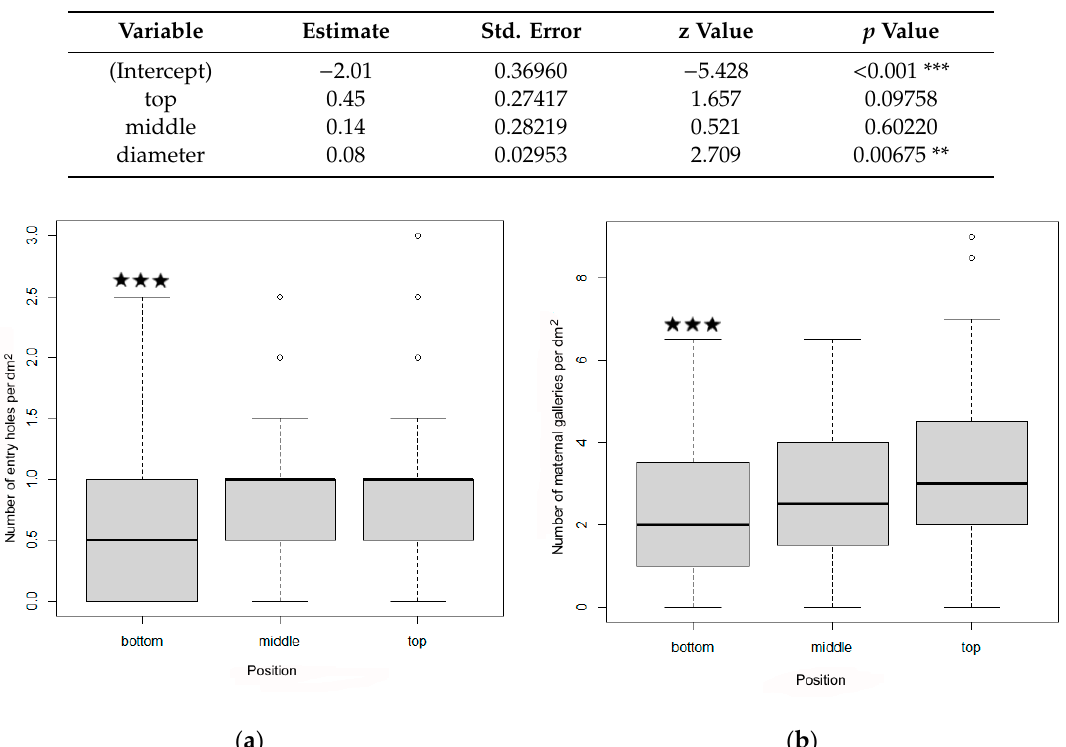
Table 5. Results of a GLM model describing the relationship between the number of maternal galleries of Ips cembrae per dm 2 and the following variables in experiment 1: position on the log (top, middle, or bottom = included in Intercept); diameter. Corrected Akaike’s Information Criterion (AIC) = 330.33. Number of Fisher Scoring iterations was 4. *** and ** indicate significance at p < 0.001 and 0.01, respectively.